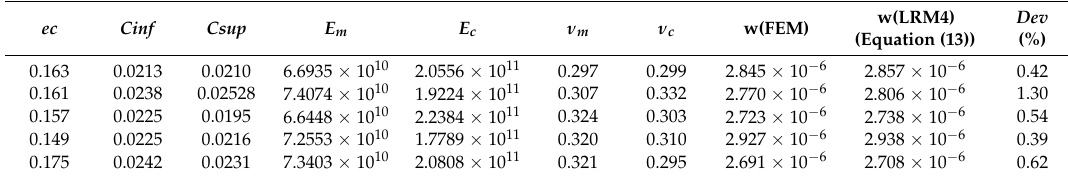
Table 14. Verification of statistic model LRM4 (case study 2, thicker